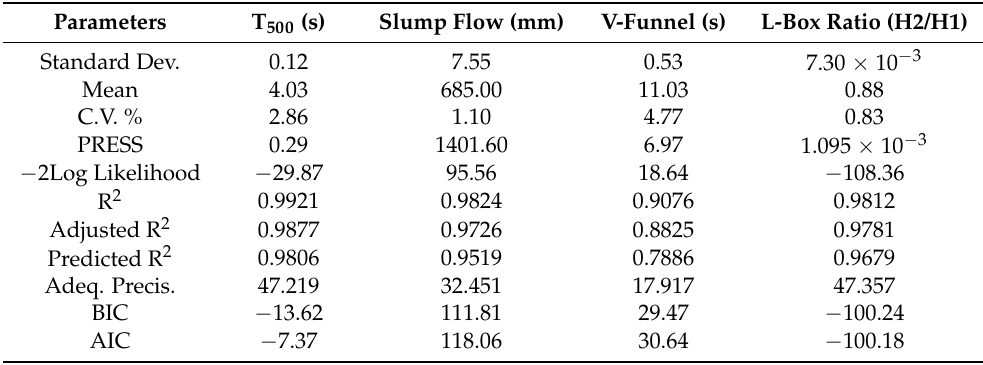
Table 3. Model validation